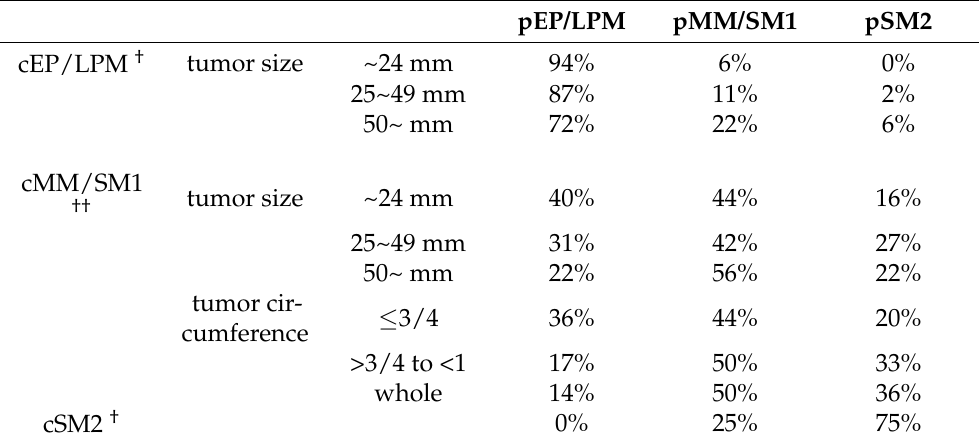
Table 1. The positive predictive value (PPV) for comprehensive diagnosis of cancer invasion depth according to tumor size or